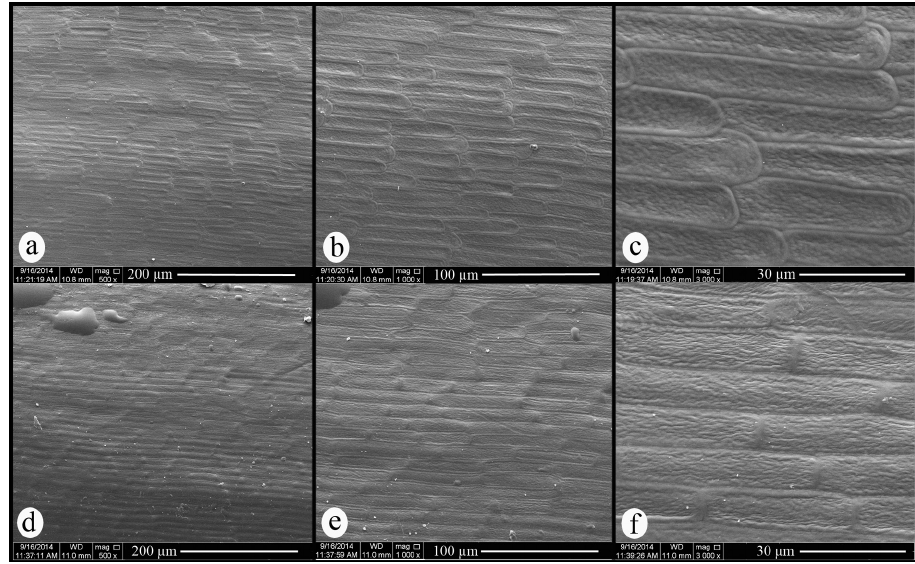
Figure 3. Scanning electron micrographs of achene surface. ( a–c ) C. ziganensis . ( d–f ) C. drabifolioides